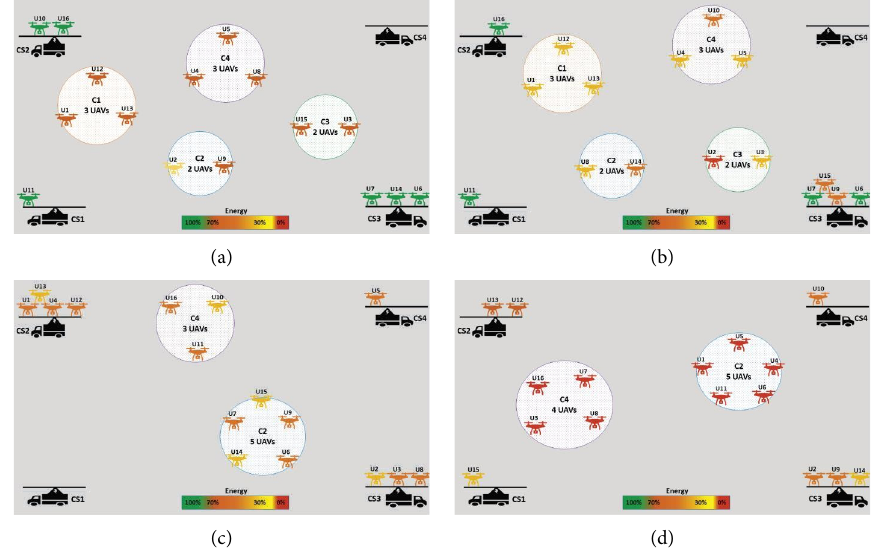
Figure 4: Simulation of the solution given by MILP-MPCT model. (a) Assigning UAVs period 1. (b) Assigning UAVs period 2. (c) Assigning UAVs period 3. (d) Assigning UAVs period